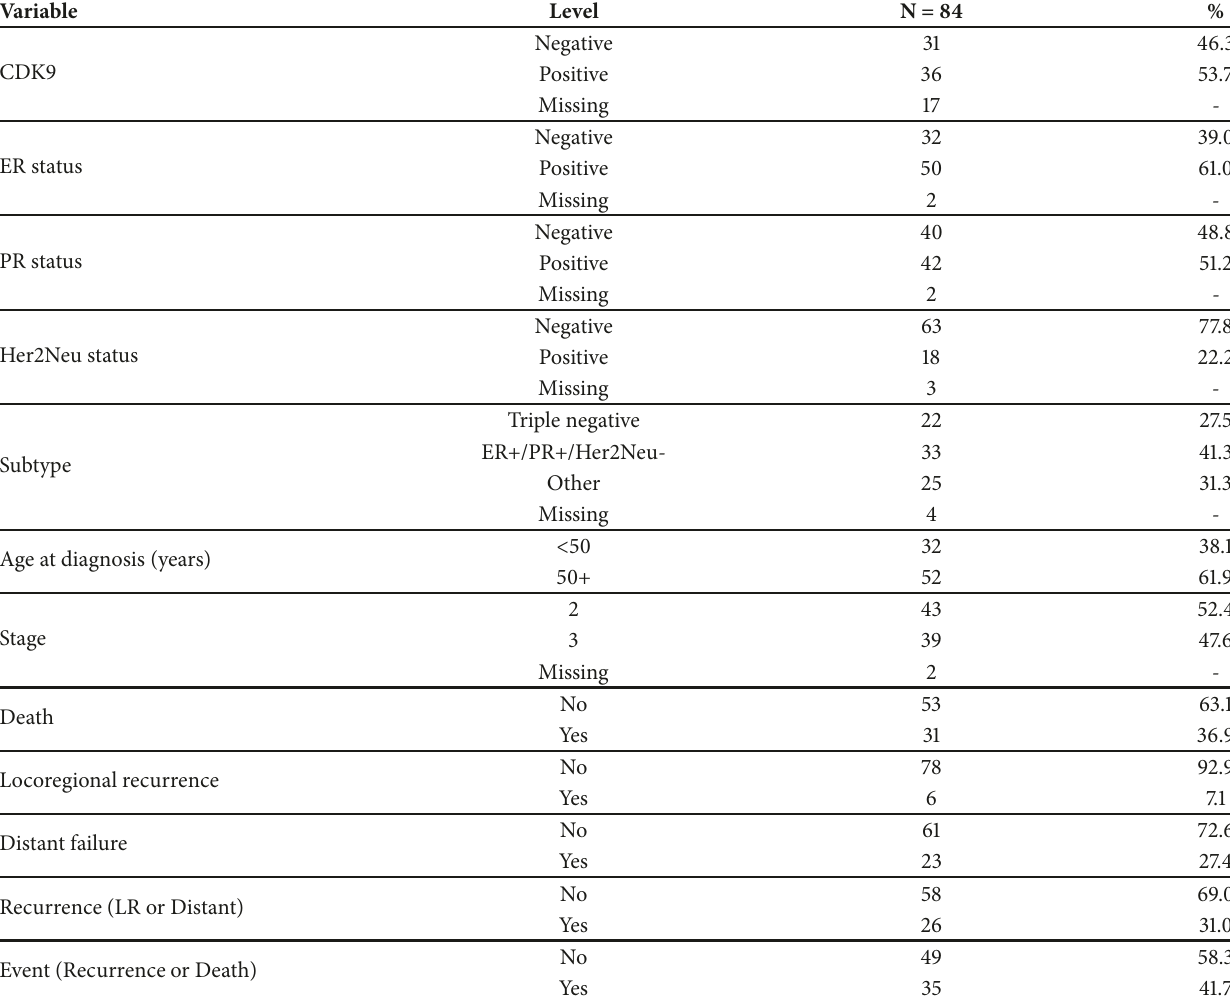
Table 1: Descriptive Statistics . This table shows clinicopathologic characteristics of the study participants including demographic informa- tion, tumor characteristics, and survival data.